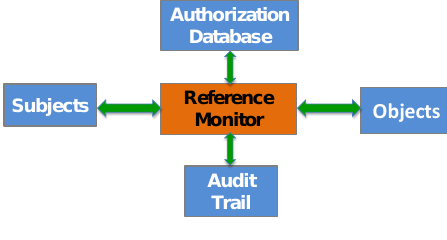
Figure 1. Reference Monitor concept.